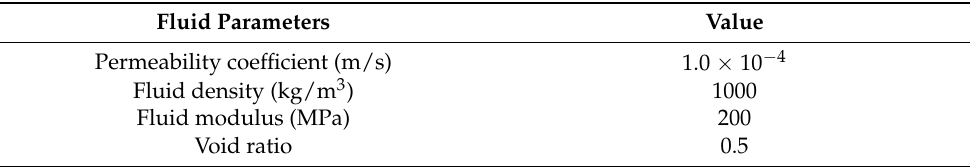
Table 2. Summary of fluid